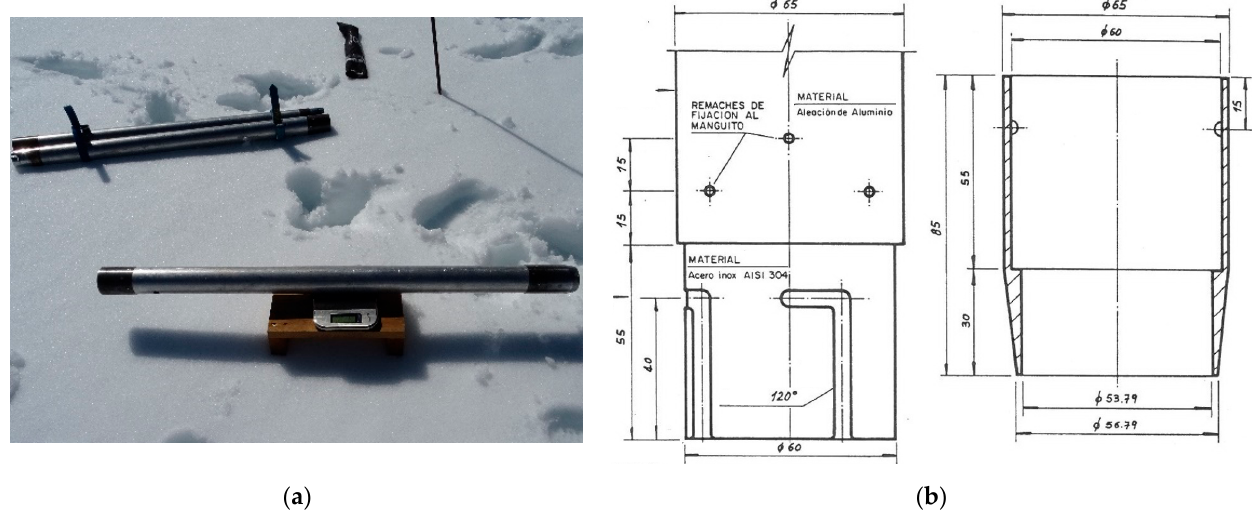
Figure 2. On-site manual sampling. ( a ) Snow tubes. ( b ) Nozzle dimensions.